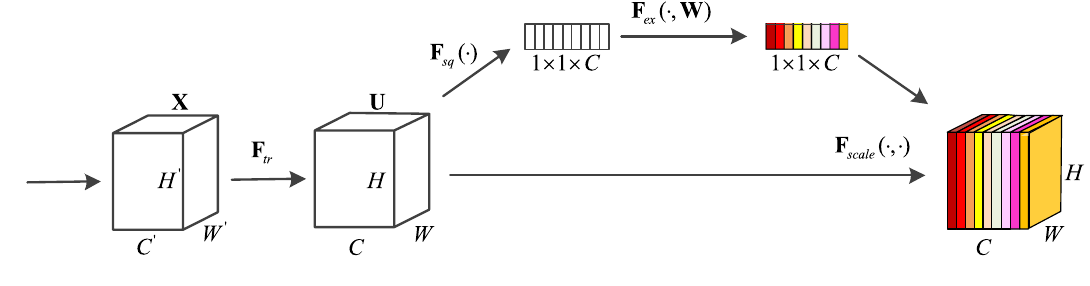
Figure 2. A squeeze-and-excitation block.